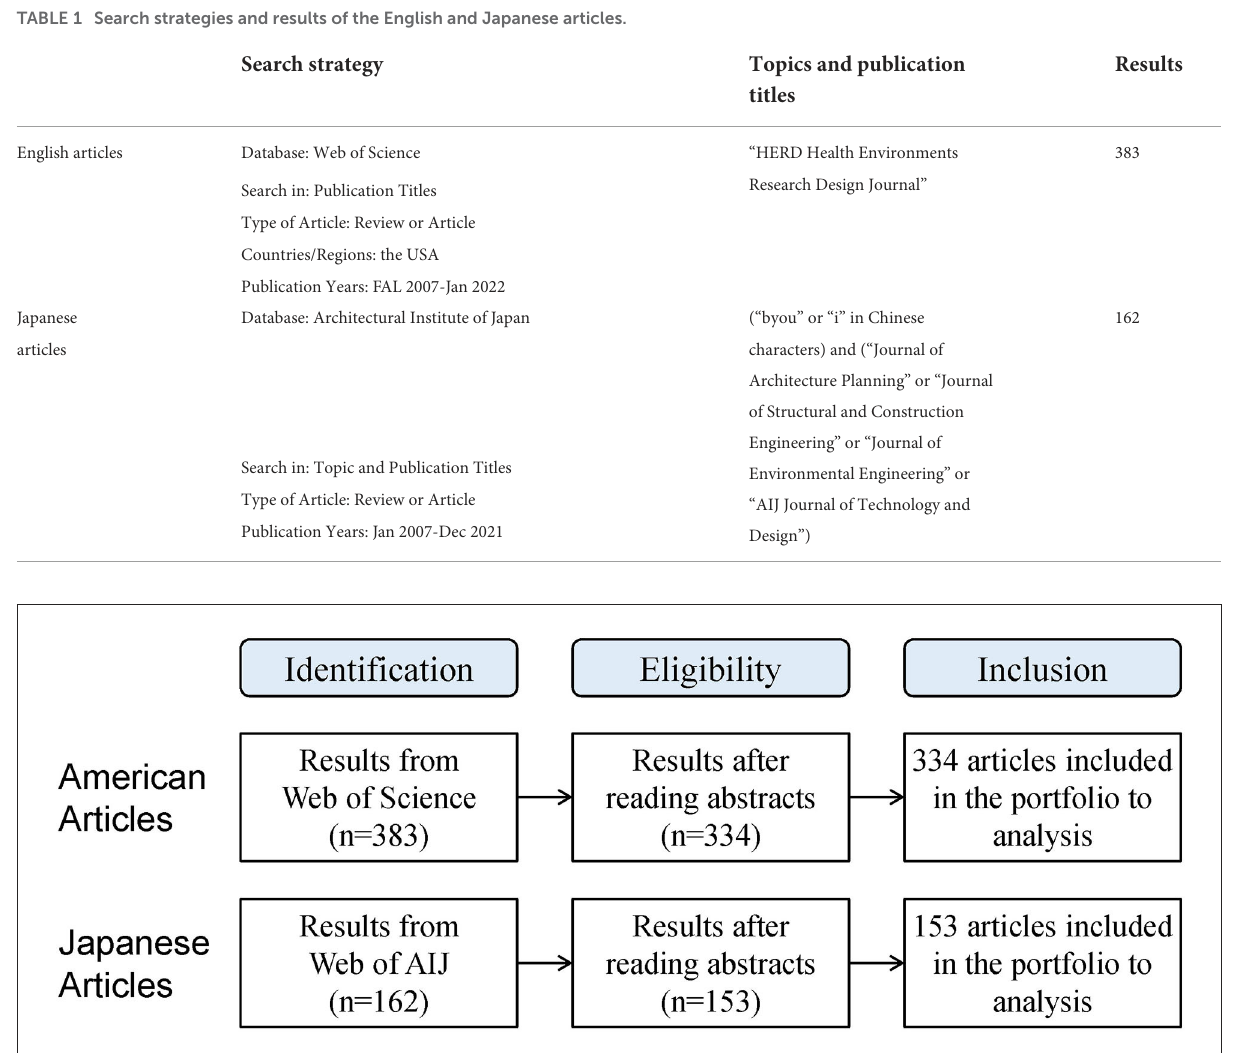
FIGURE1 Obtaining the articles for